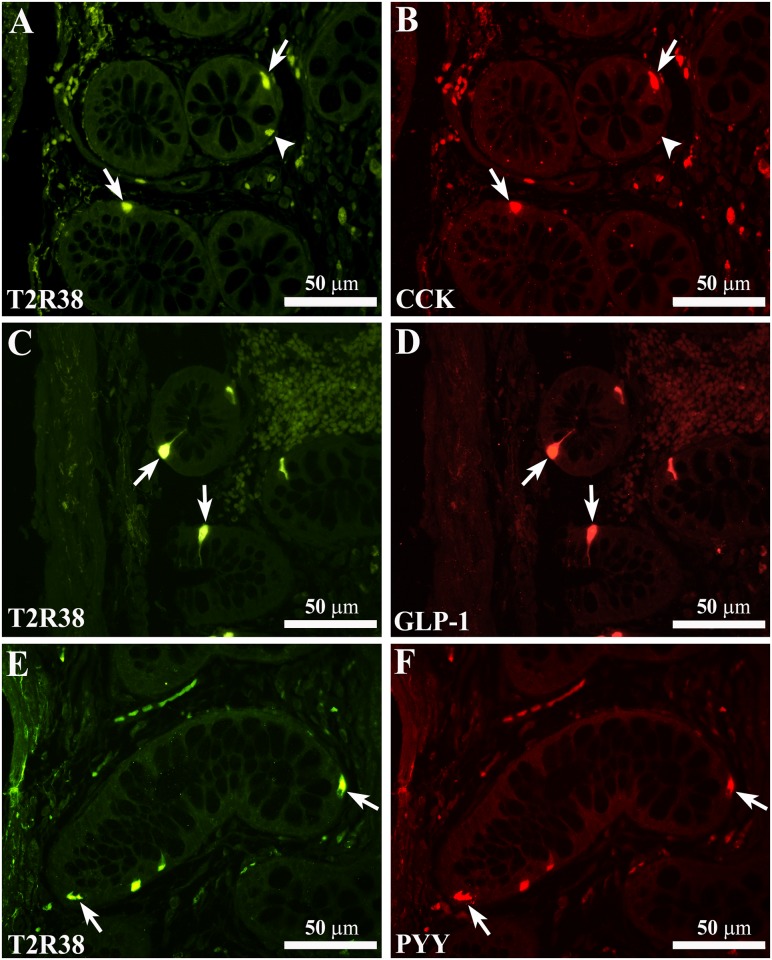
Colocalization of T2R38-IR with CCK-, GLP-1- or PYY-IR immunoreactivity.Confocal images showing T2R38-IR cells (A, C and E, arrows) containing immunoreactivity for CCK (B), GLP-1 (D) or PYY (F). The arrowheads in A and B indicate a T2R38-IR cell not containing CCK-IR. Calibration bar: 50μm.